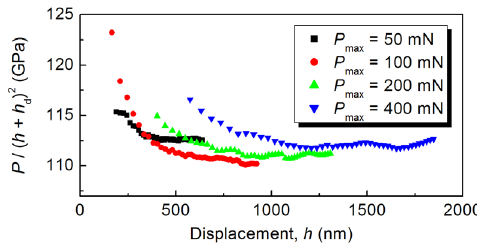
Fig. 4 Experimentally determined P /( h + h d ) 2 as functions of displacement h for different maximum load ( h d = 22.09 nm).